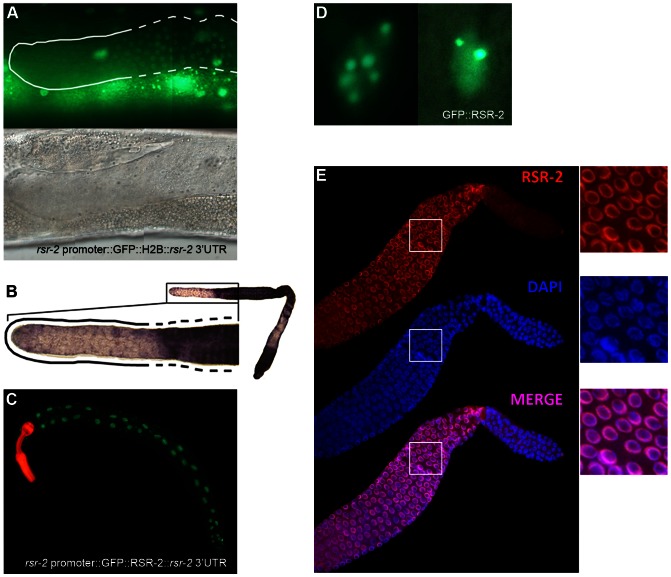

rsr-2 expression in the soma and in the germline.(A) Expression of the transgene cerEx01[rsr-2 promoter::GFP::H2B::rsr-2 3′ UTR] in the germline as complex array. Upper panel: detail of the distal part of the germline showing expression of GFP::H2B in the transition and meiotic zone (broken line) but not in the mitotic zone (continuous line). Bottom panel: corresponding Nomarski image. (B) Representative image of rsr-2 mRNA in wild type germline detected by in situ hybridization (n = 56). Magnification of the distal part of the germline (left). The broken line labels the transition and meiotic areas whereas the continuous line marks the mitotic zone. (C) Expression of the transgene cerEx04[rsr-2 promoter::GFP::rsr-2 genomic fragment (exons, introns and 3′ UTR)]. myo-2::mcherry was used as a control of transformation. (D) GFP::RSR-2 forming nuclear speckles in a hypodermal cell nucleus (left) and a neuronal nucleus (right). (E) Confocal images of anti-RSR-2 immunofluorescence in the germline. Nuclei counterstained with DAPI. The three pictures on the right correspond to magnified images of the white boxes.